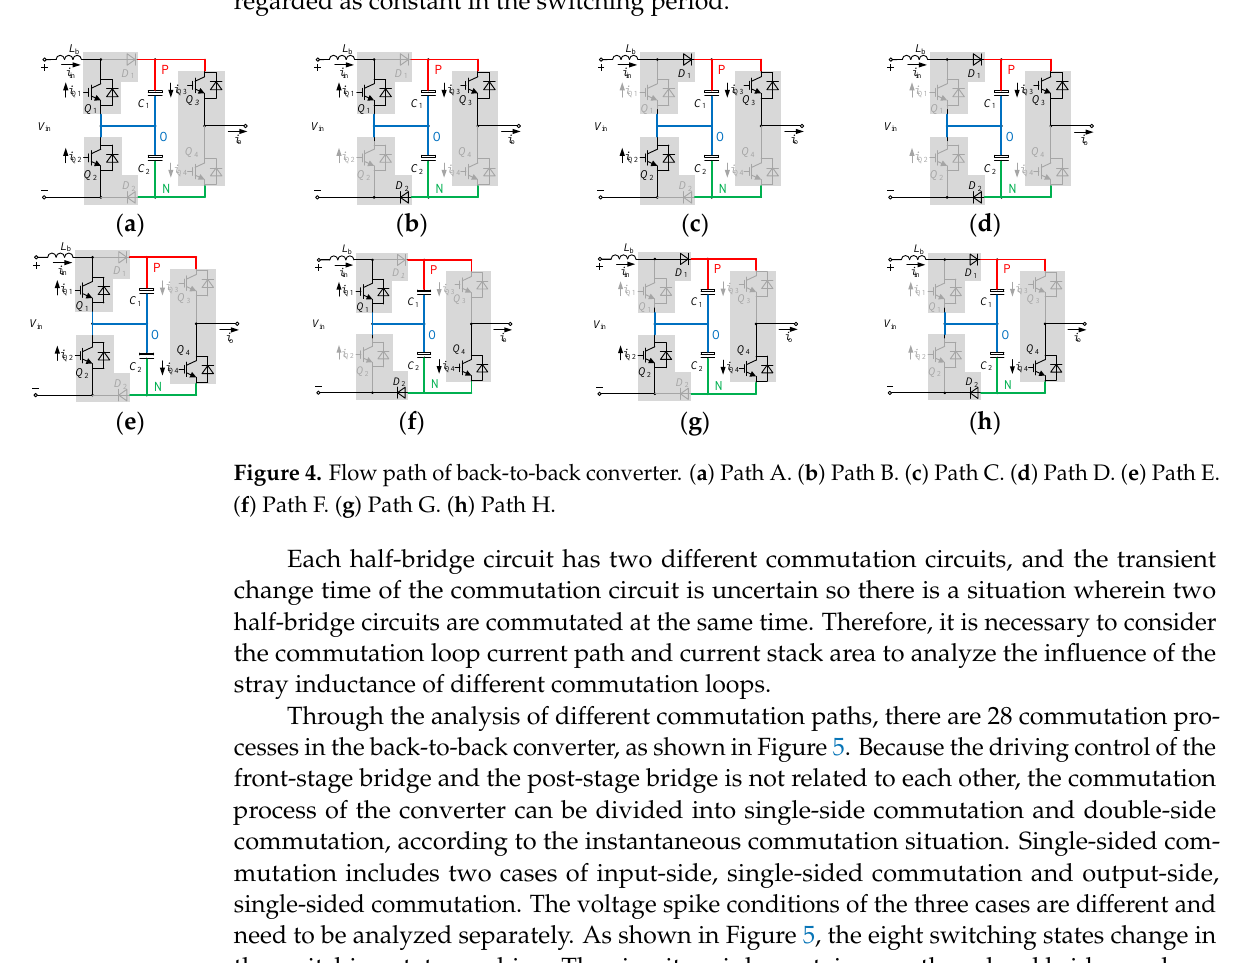
Figure 3. Circuit topology of back-to-back converter.